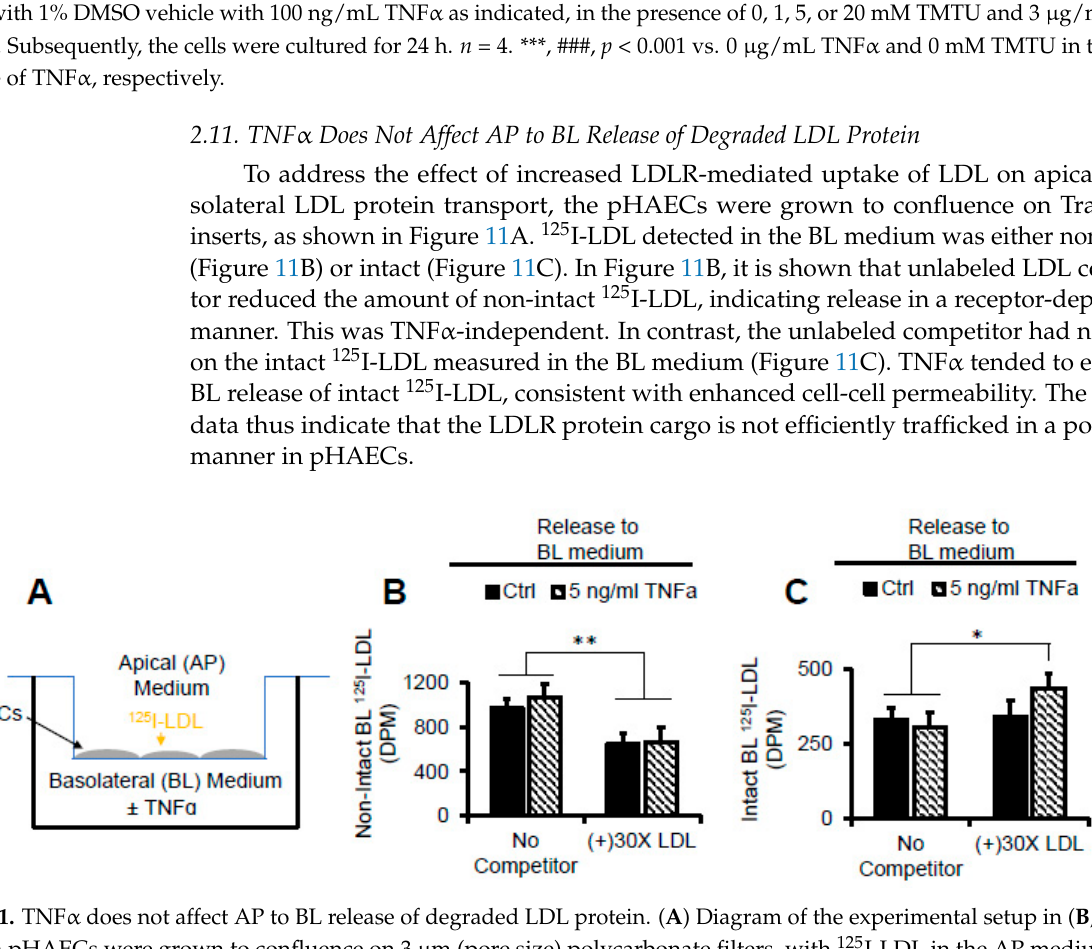
3 µ g/mL Dil-LDL, with 100 ng/mL TNF α , as indicated, was added, followed by 24 h incubation. n = 3. ( B ) Cells were µg/mL Dil-LDL. Subsequently, the cells were cultured for 24 h. n = 4. ***, ###, p < 0.001 vs. 0 µg/mL TNF ɑ and 0 mM TMTU